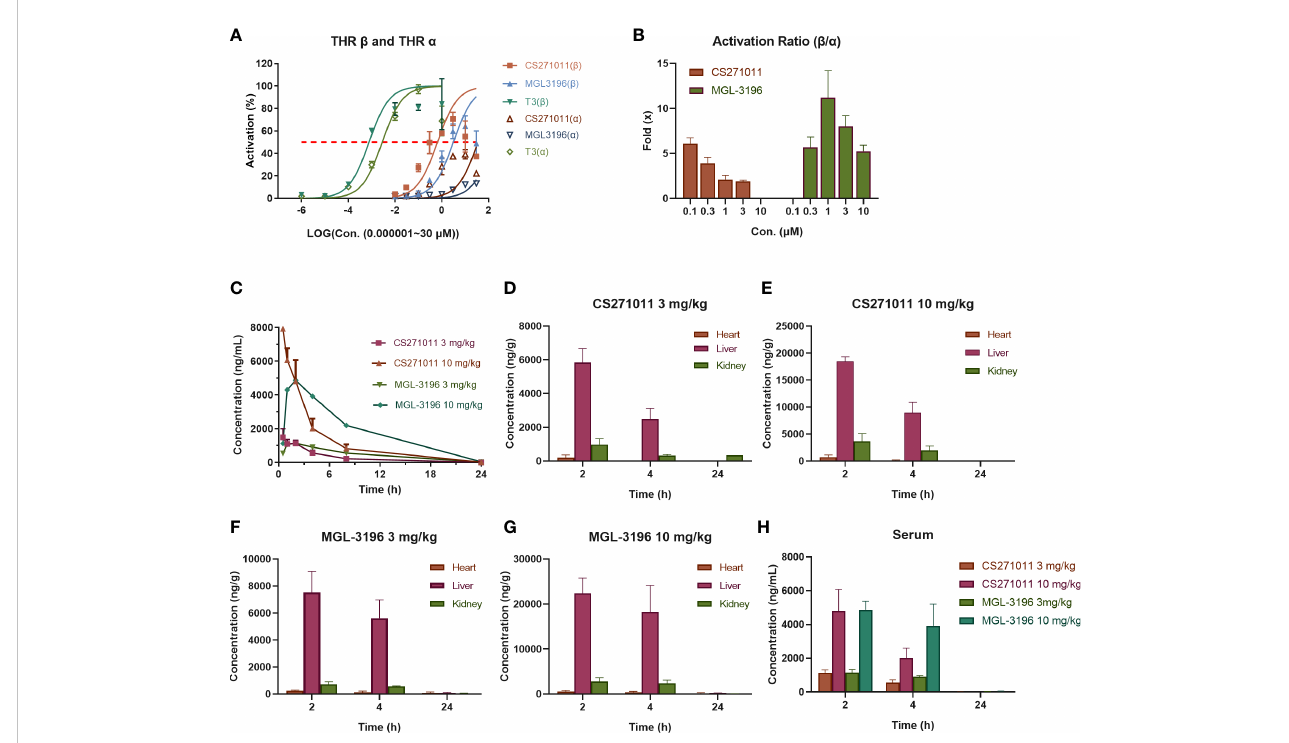
FIGURE 1 Selective activation of thyroid hormone receptors b and a and pharmacokinetics (PK) of CS271011 and MGL-3196 (n=3 for each subgroup). (A) Activation of thyroid hormone receptor b and a ; (B) Selective activation ratio of thyroid hormone receptor b over thyroid hormone receptor a ; (C) Serum pharmacokinetic curve of normal mice treated with CS271011 (3 mg/kg and 10 mg/kg) and MGL-3196 (3 mg/kg and 10 mg/kg) orally once. Tissue distribution studies of CS271011 3 mg/kg (D) , CS271011 10 mg/kg (E) , MGL-3196 3 mg/kg (F) and MGL-3196 10 mg/kg (H) ; (G) The serum concentration change of CS271011 and MGL-3196 with different dosages. The red dashed line of (A, B) indicates 50% activation of thyroid hormone receptor isoforms. All data are presented as the mean ± SD. T3,